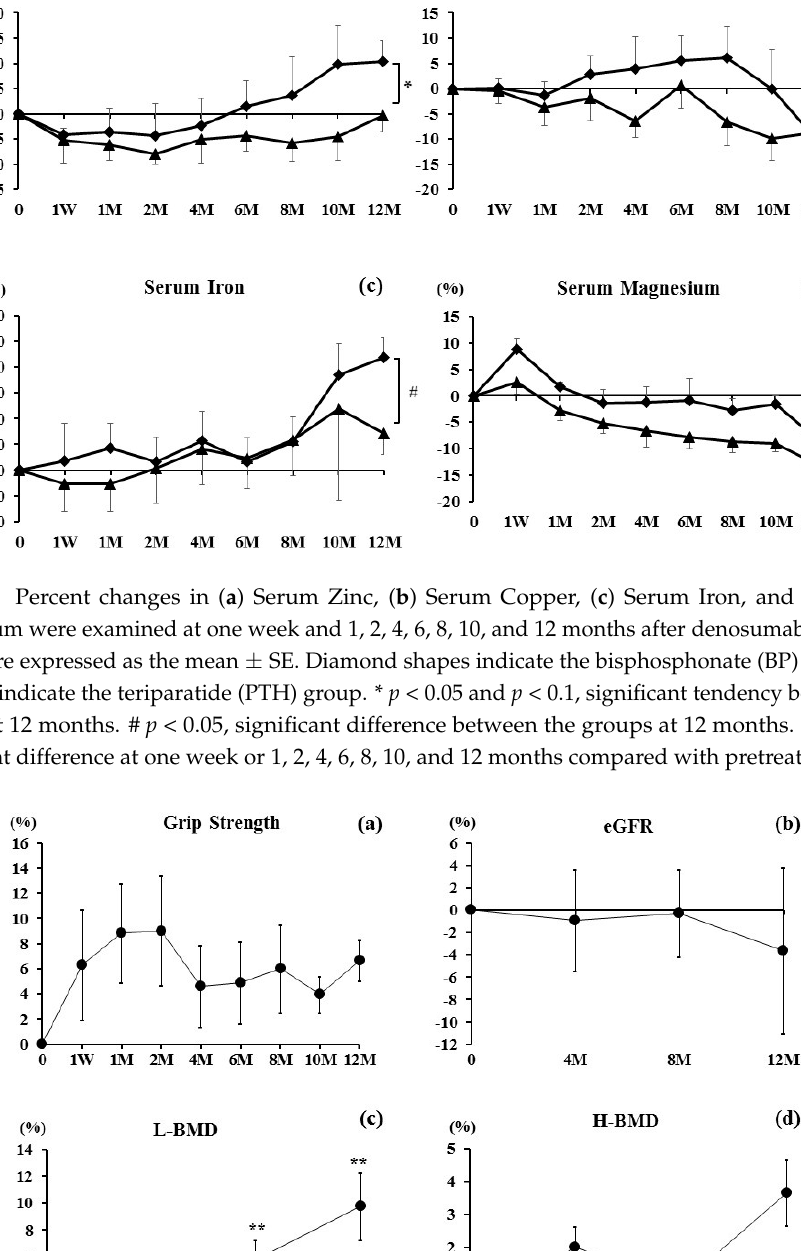
Figure 3. Percent changes in ( a ) Grip Strength and ( b ) Estimated Glomerular Filtration Rate (eGFR) were examined at one week and 1, 2, 4, 6, 8, 10, and 12 months after denosumab treatment. Percentage changes in bone mineral density (BMD) of ( c ) L1 to L4 lumbar vertebrae (L-BMD) and ( d ) bilateral